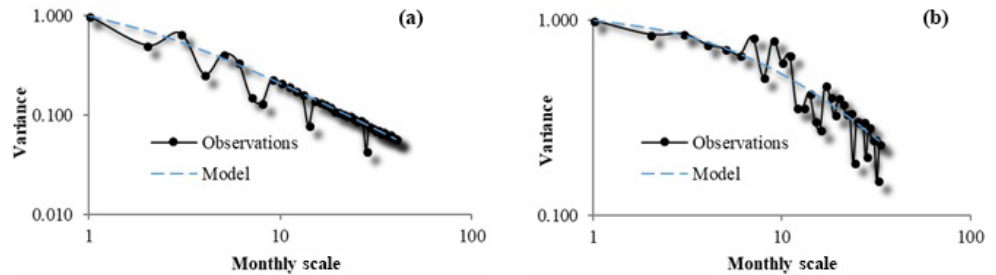
Figure 6. Climacogram for salinities in two different stations in Florida (SSW28” and DSW40” respectively).